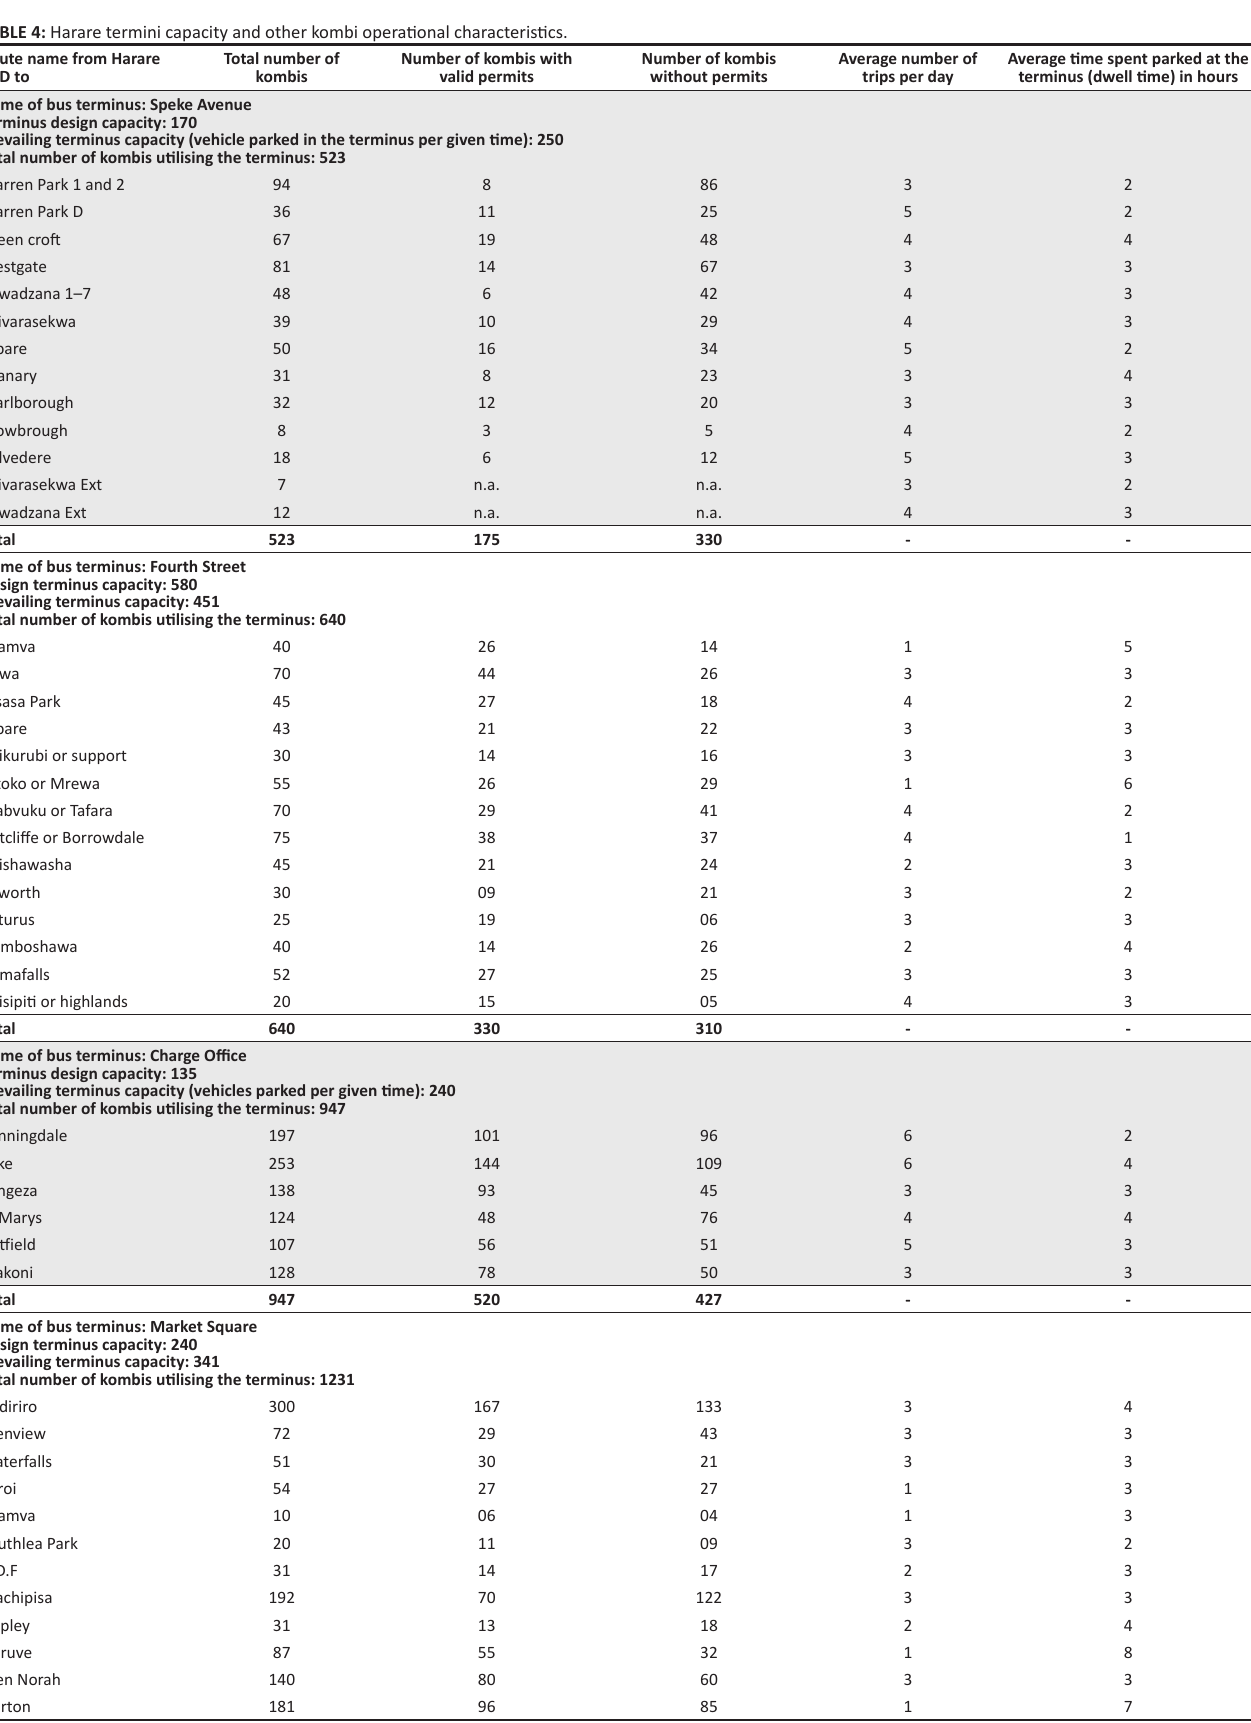
TABLE 4: Harare termini capacity and other kombi operational characteristics. Route name from Harare CBD to